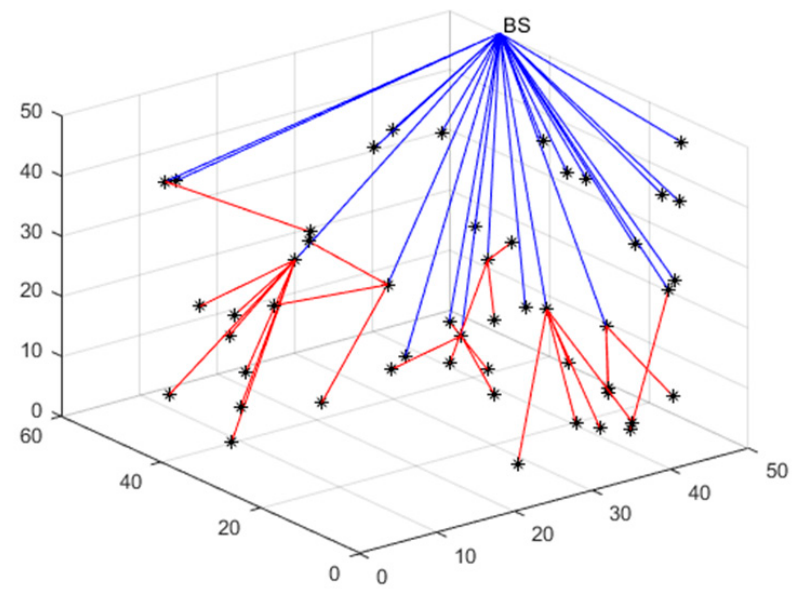
Figure 5. Multi-hop communication